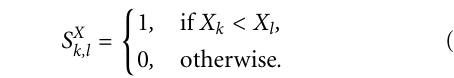
Figure 4: (a) The distance map generated for the “bird-19” contour in Figure 1, (b) a 3D view of this distance map.